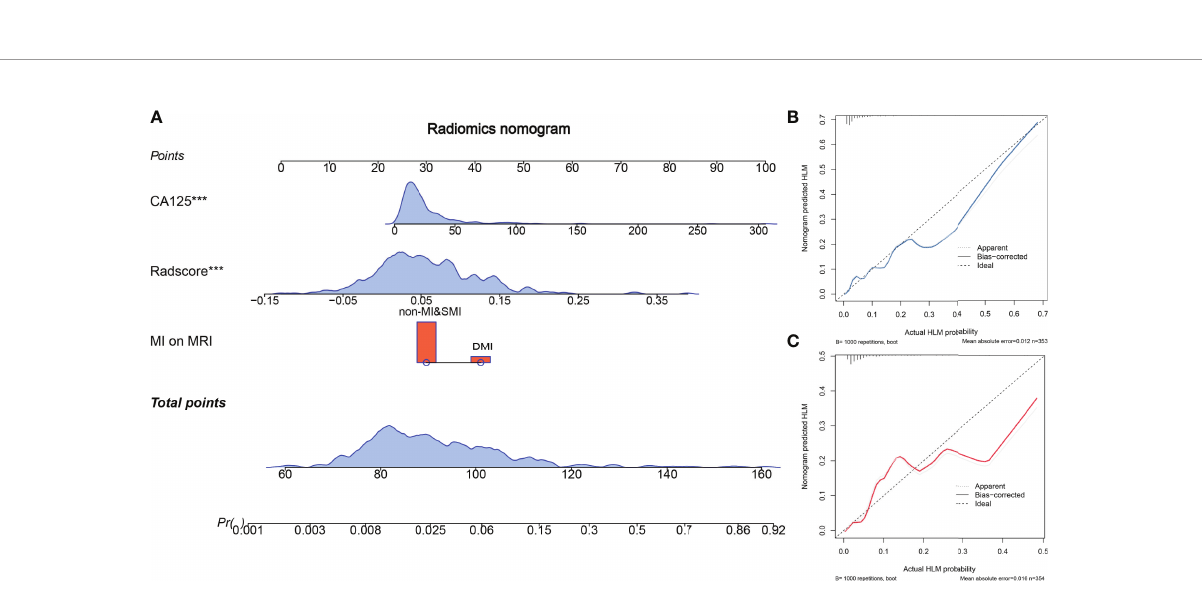
FIGURE 3 | The radiomics nomogram and calibration curves. The radiomics nomogram is constructed by integrating CA125, radscore, and myometrial invasion (MI) on MRI (A) . Calibration curve of the radiomics nomogram for predicting LNM in the training cohort (B) and the test cohort (C)